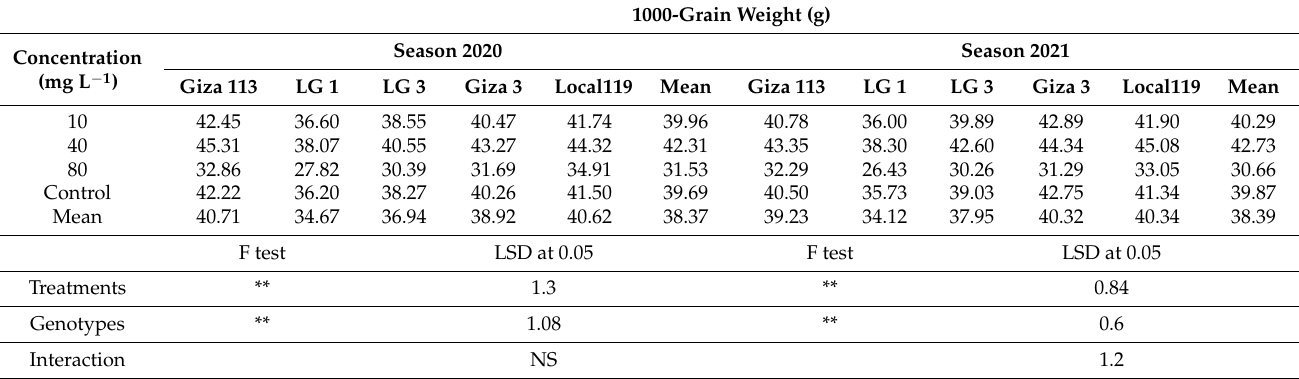
Table 6. Effect of Fe 3 O 4 /HA NPs on the 1000-grain weight of grain sorghum during the seasons of 2020 and 2021. 1000-Grain Weight